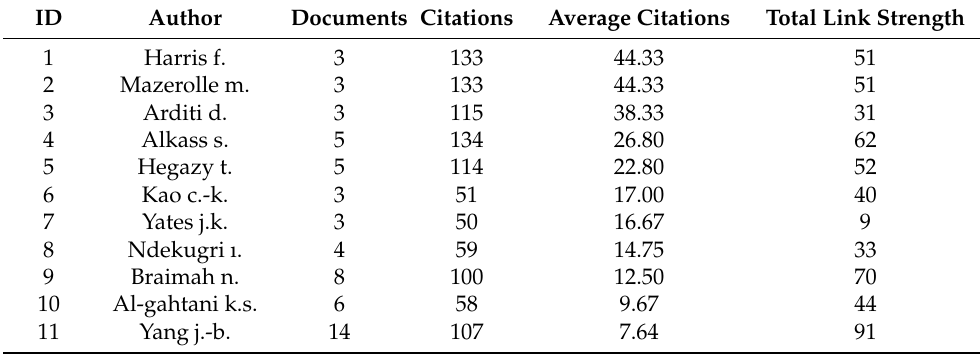
Table 4. Documents and citations of authors.